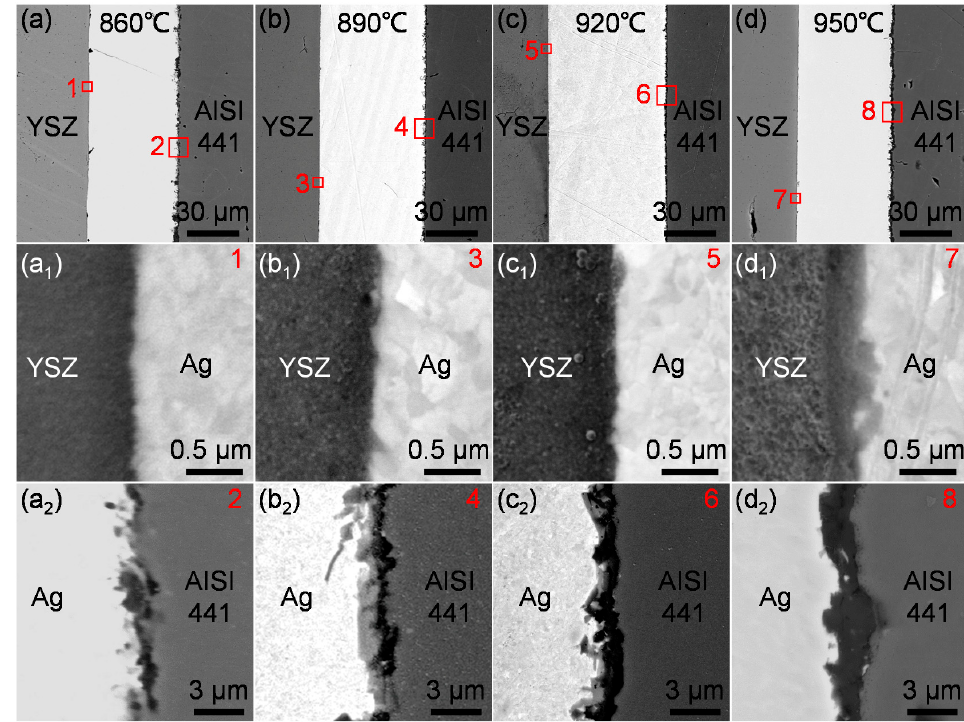
Figure 5. Microstructure of joints obtained at ( a ) 860 °C, ( b ) 890 °C, ( c ) 920 °C, and ( d ) 950 °C; ( a 1 – d 1 ) enlarged view at the YSZ/Ag interface; ( a 2 – d 2 ) enlarged view at the Ag/AISI 441